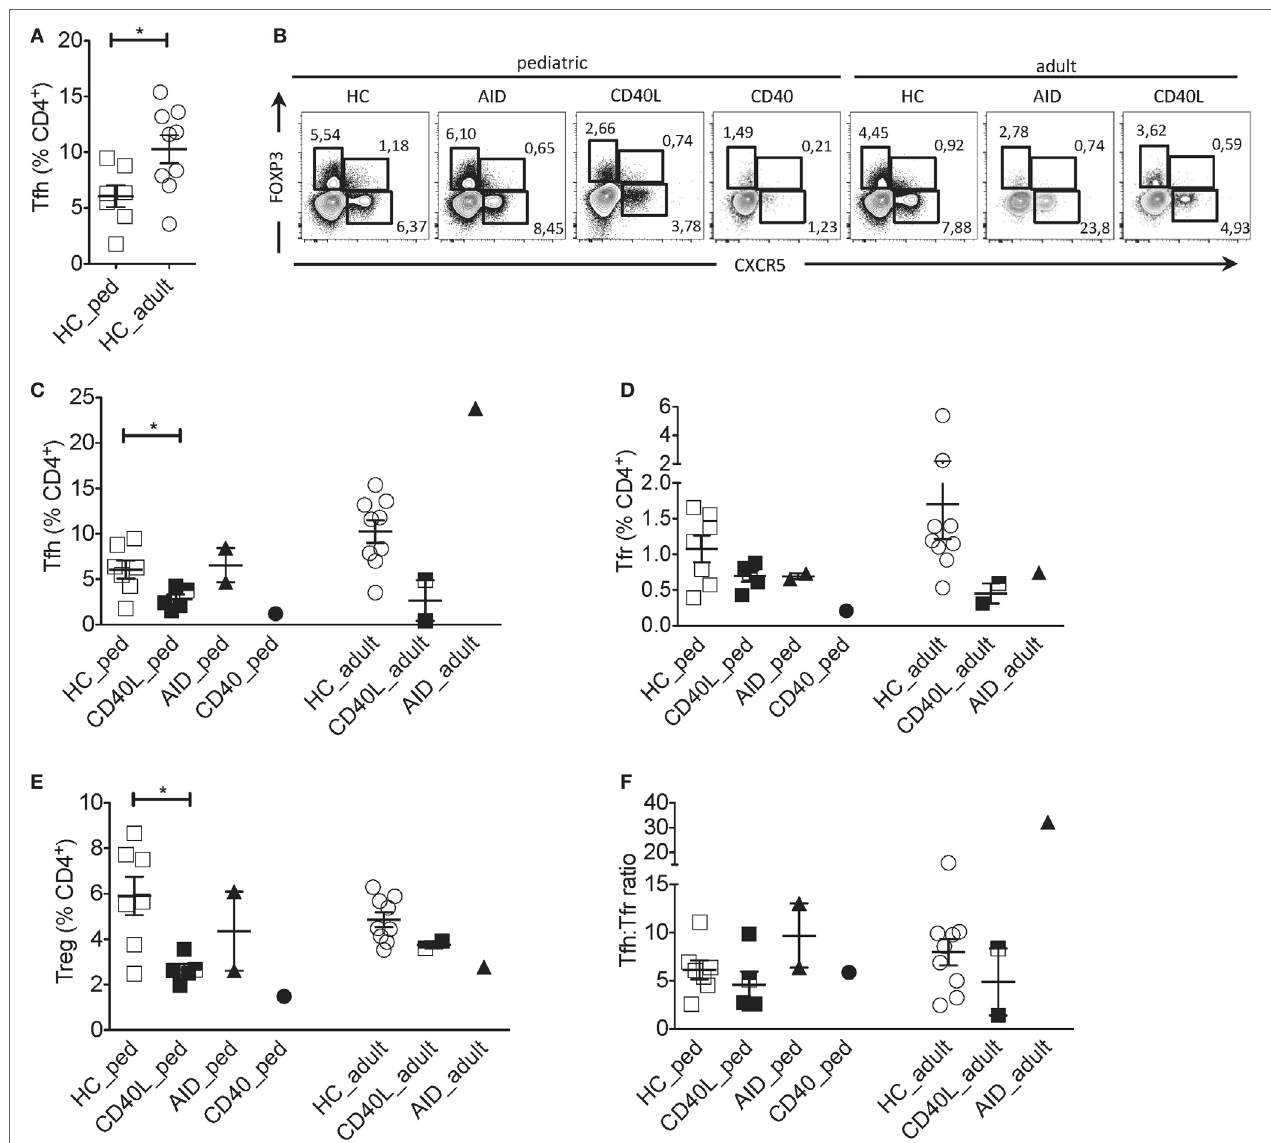
FIGURe 1 | Circulating Tfh and Tfr cells in an individual with CD40 deficiency compared to patients with CD40L and AICDA mutations. (a) Percentage of Tfh (gated on singlets → lymphocytes → CD3 + CD19 − CD14 − CD8 − → CD4 + CD3 + ) in healthy pediatric (3–15 years, n = 7, HC_ped) and healthy adult (19–31 years, n = 9; HC_adult) healthy controls (HCs). (B) Representative flow cytometry plots for Tfh (CXCR5 + FOXP3 − ), Tfr (CXCR5 + FOXP3 + ), and T regulatory (Treg) (CXCR5 − FOXP3 + ) cells, gated on singlets → lymphocytes → CD3 + CD19 − CD14 − CD8 − → CD4 + CD3 + in hyper-IgM (HIGM) patients and age-matched HCs. (C–e) Percentage of Tfh (C) , Tfr (D) , and Treg (e) cells in pediatric [CD40 ligand (CD40L), n = 5; activation-induced cytidine deaminase (AID), n = 2; CD40, n = 1] and adult (CD40L, n = 2; AID, n = 1) HIGM patients, compared with age-matched HCs [same as in panel (a) ]. (F) Tfh:Tfr ratio cells in pediatric and adult HIGM patients (AID, CD40L, and CD40 deficiency, as indicated) compared with age-matched HCs. Bars: mean ± SEM. * p < 0.05 (Mann–Whitney test). Each dot represents one patient. Black & white squares represent longitudinal measurements of the same CD40L-deficient patient, collected at 14 and 19 years of